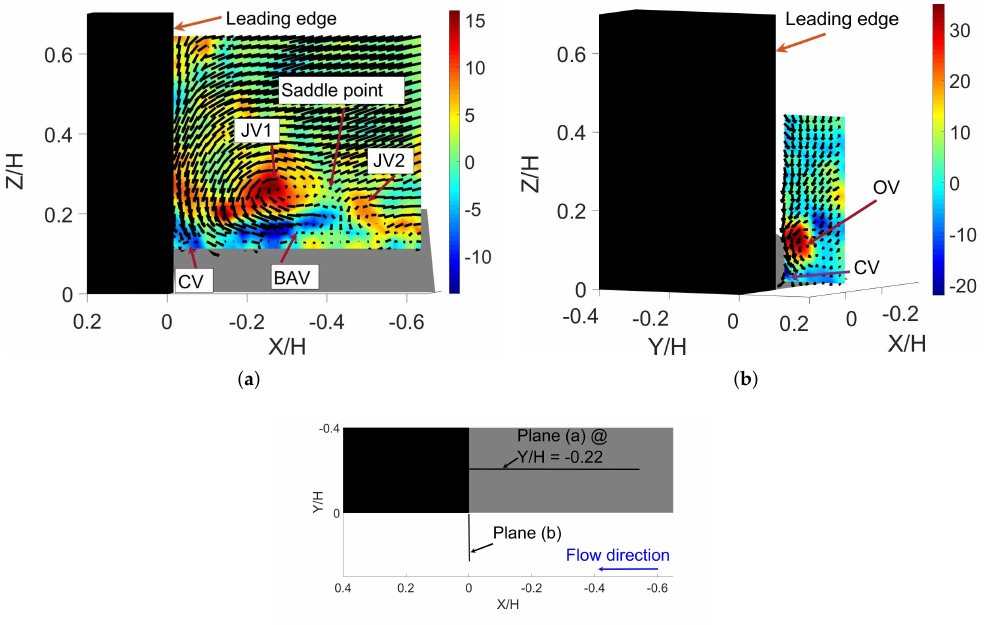
Figure 9. The dimensionless instantaneous velocity vectors over the dimensionless ( a ) spanwise, and ( b ) streamwise vorticity fields within the representative planes identified in the image inserted in the second row. The flow moves in the positive